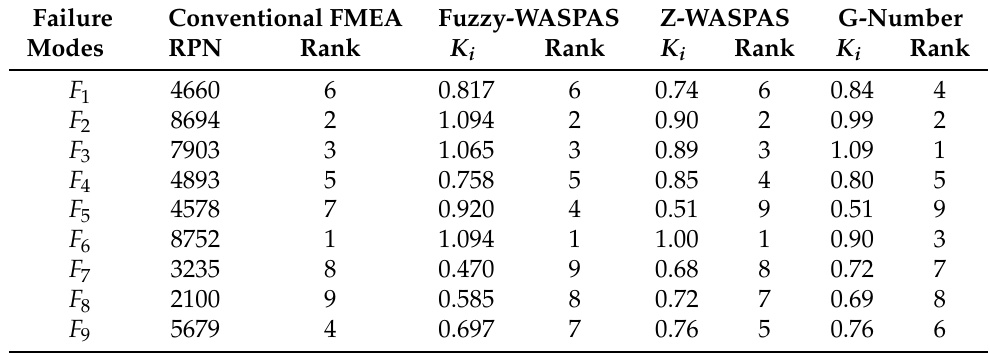
Table 21. Compared to existing strategies, the suggested methodology prioritizes failure